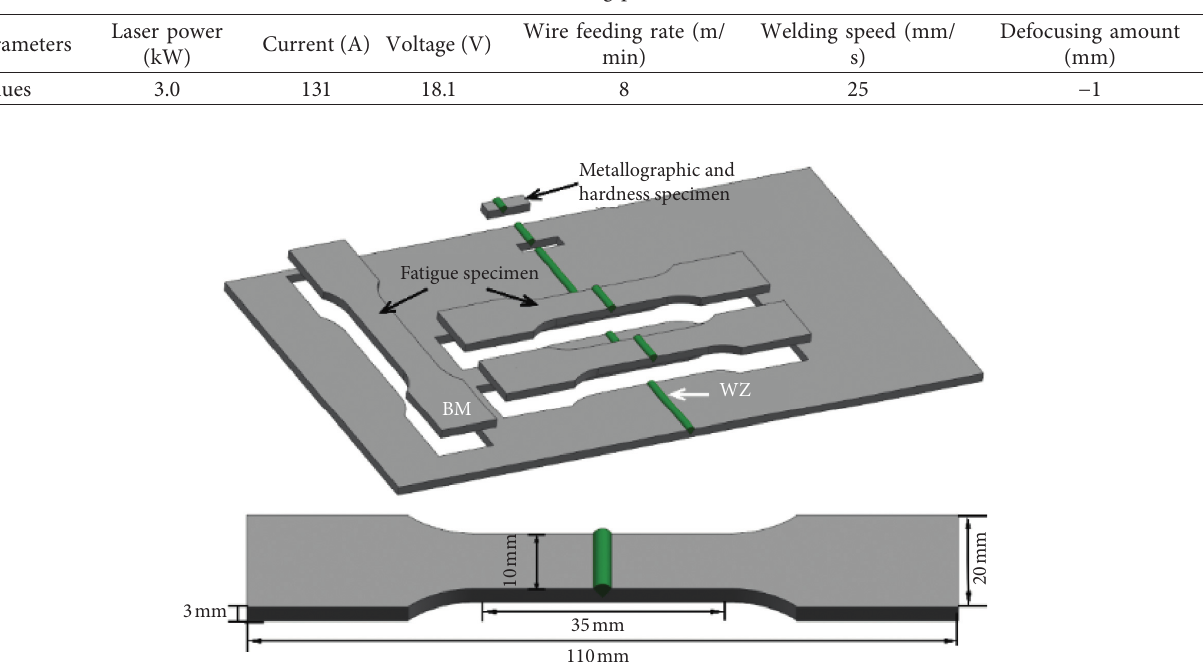
Figure 1: Schematic diagram of laser-MIG hybrid welding of 6061-T6 aluminum Table 2: Welding parameters.